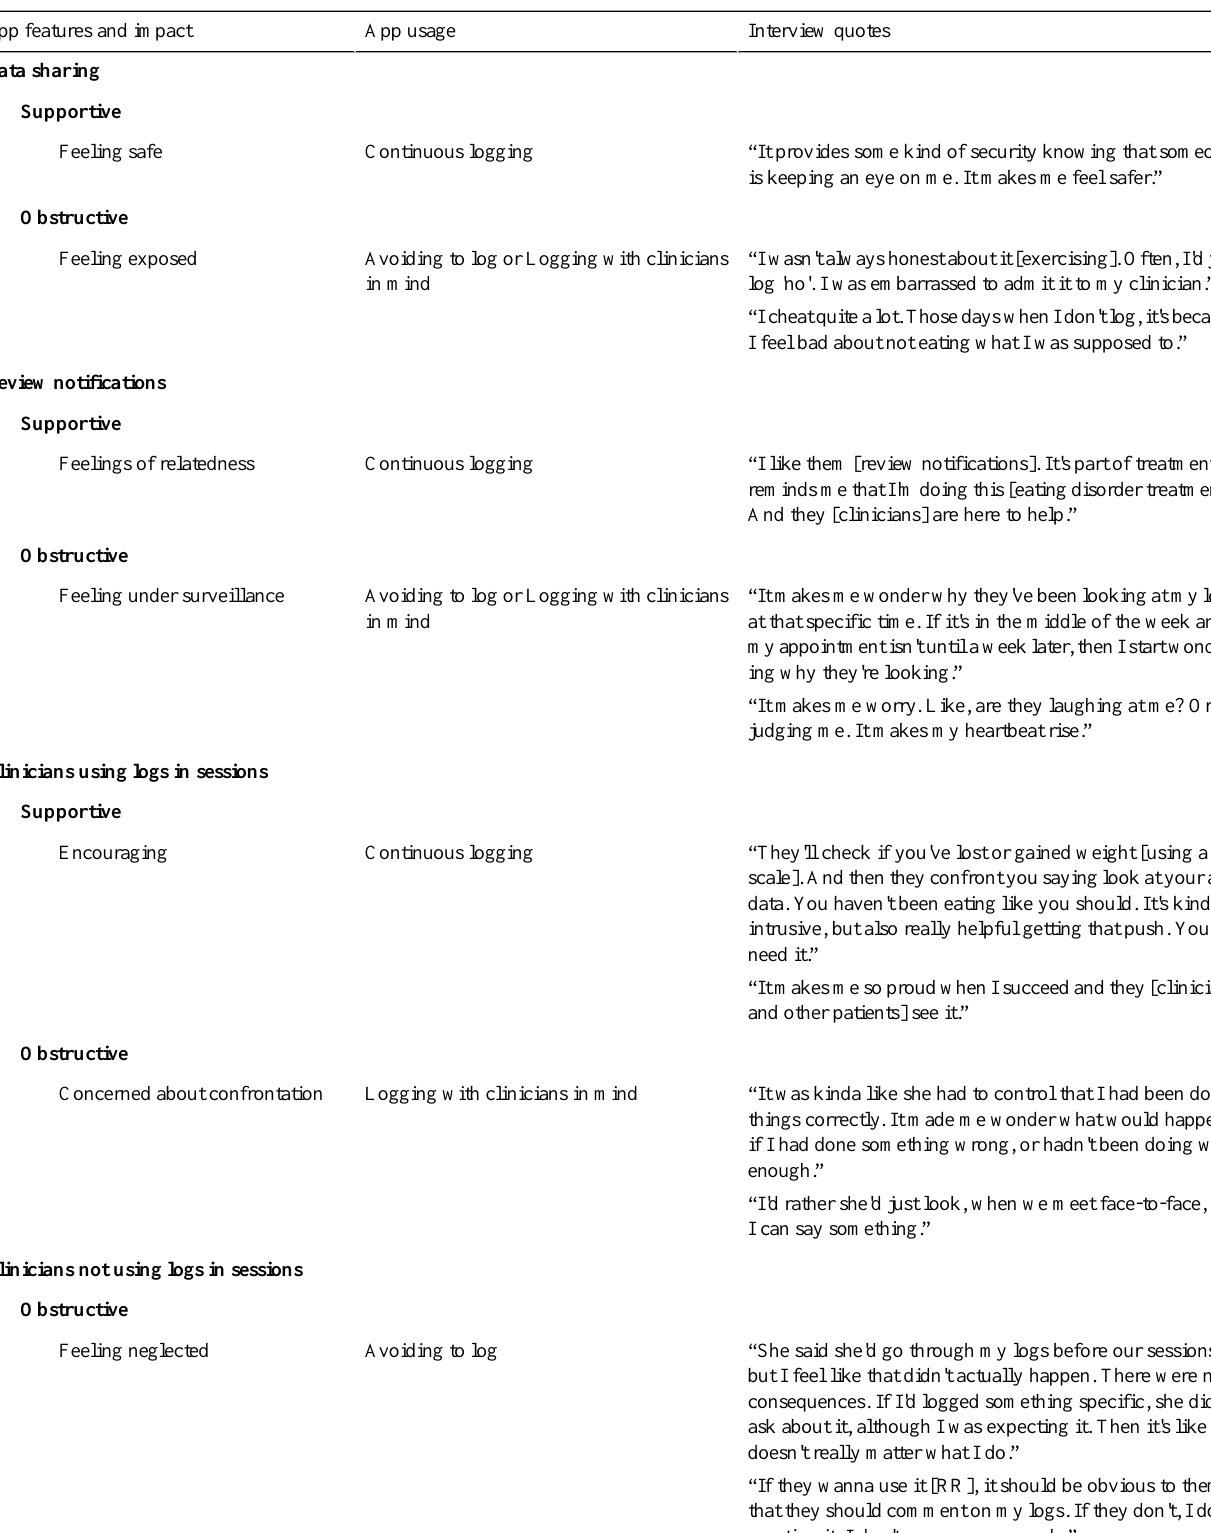
Table 6. Patients’ experiences with the patient-clinician linkage feature in Recovery Record (RR). The table summarizes the individual patient-app interaction, that is, the specific linkage features, the impact of these on patients, and patients’specific app usage supported by interview